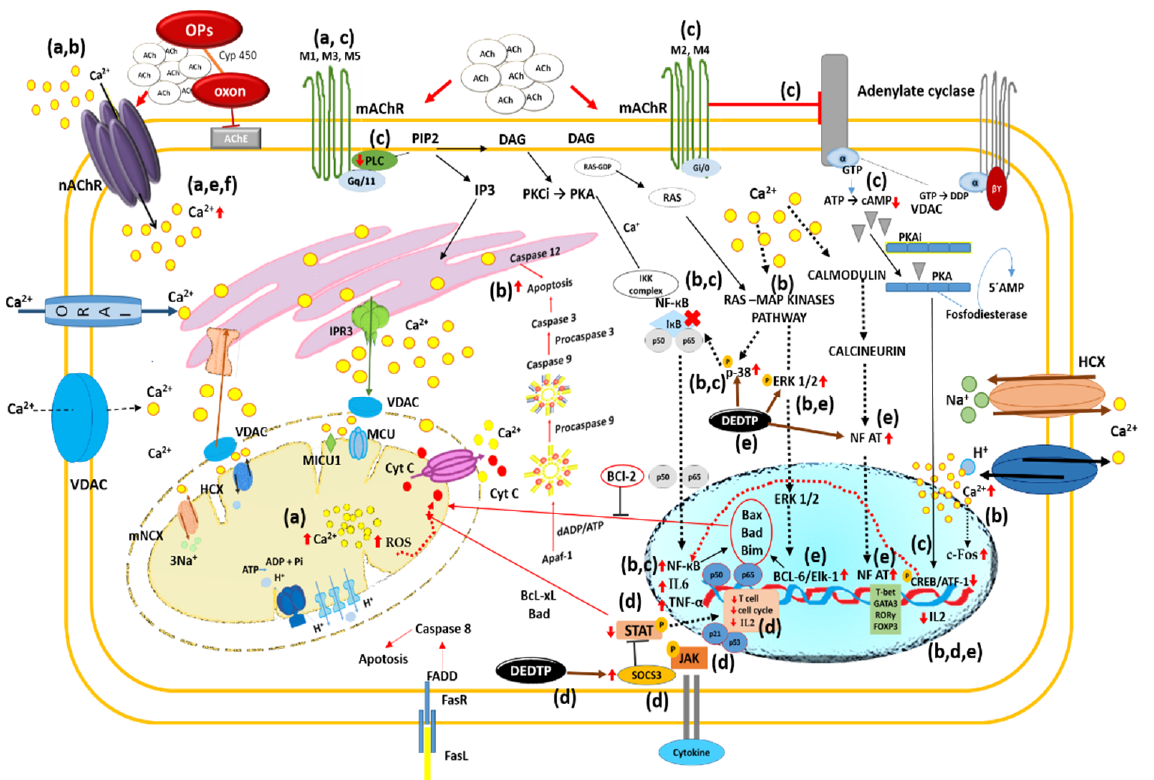
Figure 3. Modulation of signal transduction through the cholinergic system by OP exposure. Ex- posure to OPs induces AChE inhibition and ACh accumulation, leading to AChR